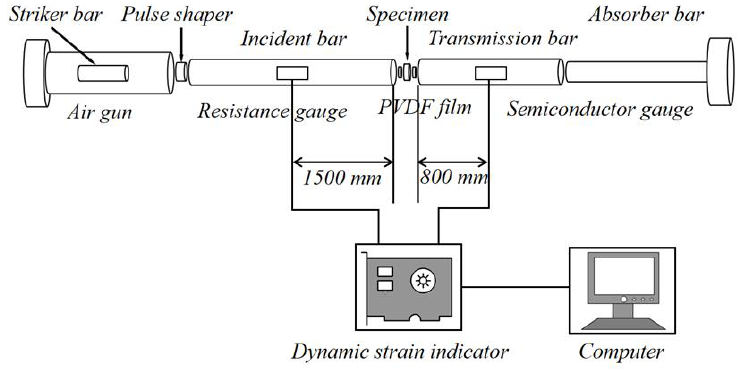
Figure 2. SHPB experimental device.